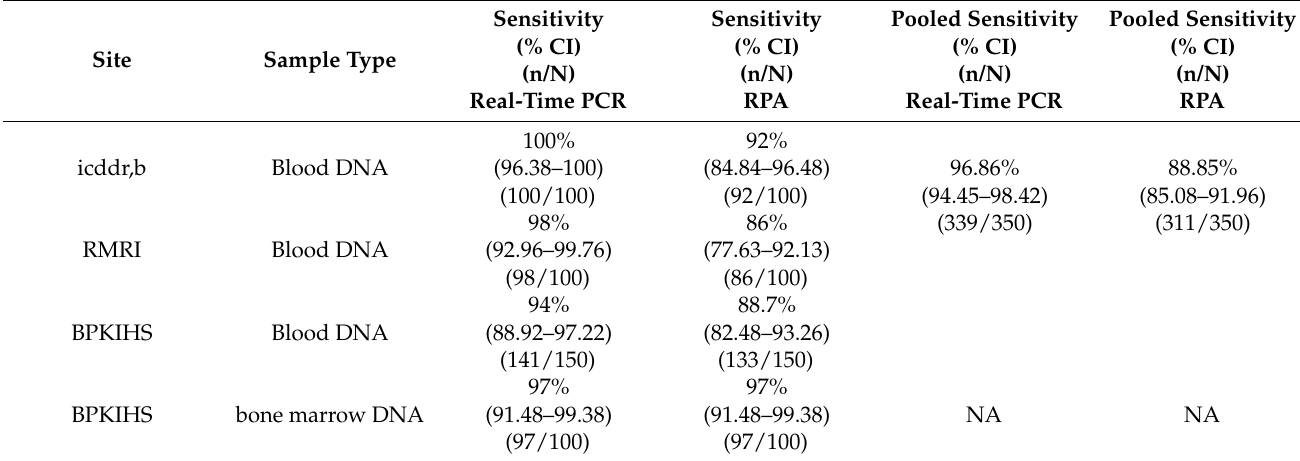
(Table 1). For PKDL, the sensitivity of the assay was variable among the centers. The sensitivity of real-time PCR was found to be three times higher in detecting the parasite DNA from blood samples of PKDL patients at RMRI, than that of the pooled sensitivity (25%) (Table 2). Since parasite is abundant in skin lesions of PKDL patients, promising sensitivity of real-time PCR was noted both at icddr,b (100%) and RMRI (93%) when DNA was isolated from skin samples (Table 2). As of PKDL, real-time PCR showed excellent positivity rate in detection of LD DNA in skin samples of CL patients where all the skin samples (N = 47) were detected positive with 100% (95% CI:92.45–100.00) sensitivity. At BPKIHS and icddr,b, the performance of real-time PCR was absolute (100%) in terms of identifying true negative healthy controls, whereas markedly lower specificity (~80%) was observed at RMRI (Table 3). In ROC analysis, blood samples were found to be excellent in determining the diagnostic accuracy of real time PCR for VL. Likewise, the assay showed optimum diagnostic accuracy when skin samples were used for PKDL (Table 5) (Figure 3). At USJ, all the collected skin samples from non-endemic controls were detected negative with 100% (95% CI:69.15–100.00) specificity. Table 1. Clinical sensitivity of both real-time PCR and LD RPA assay using blood and bone marrow samples of VL patient from three centers in Bangladesh, India, Nepal.